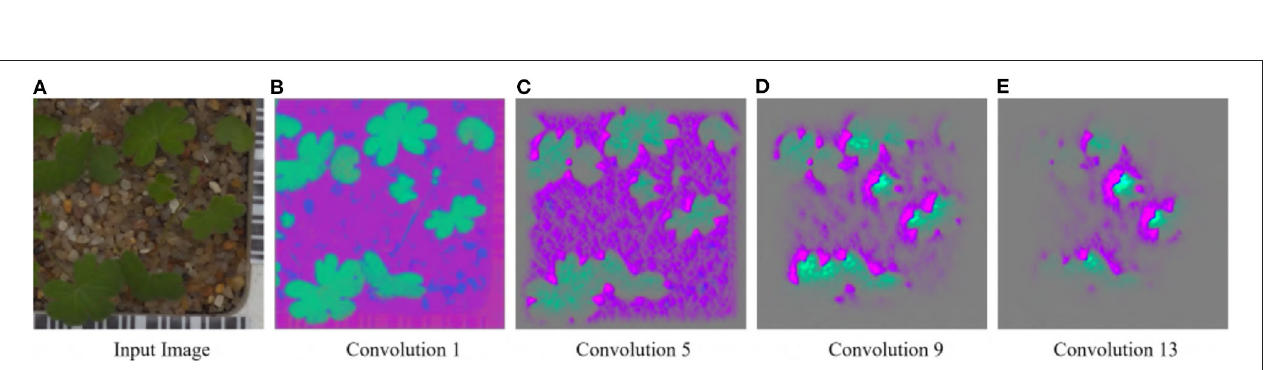
FIGURE 7 | GBP visualization of the convolutional layers of the Small-flowered Cranesbill of the Plant Seedling dataset for Shallow CNN, 13 Layers. (A) Input image. (B) Convolution 1. (C) Convolution 5. (D) Convolution 9. (E) Convolution 13.